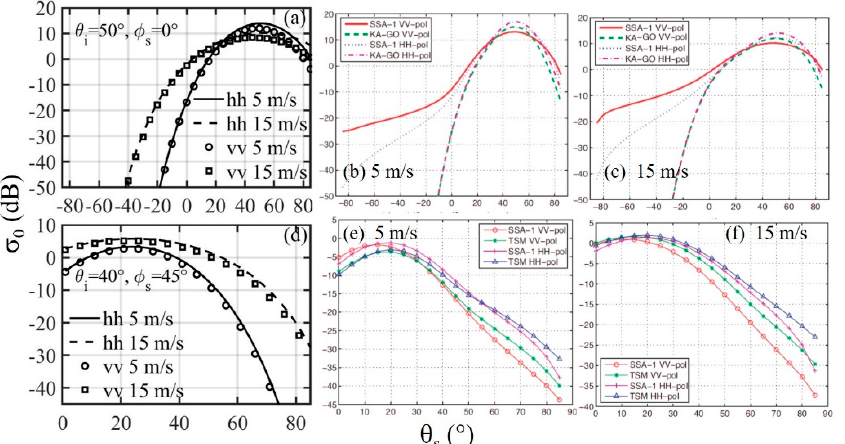
Figure 15. (Top row) Examples of in-plane NRCS dependence on θ s , f = 14 GHz, θ i = 50°. ( a ) Specu- lar point computation, U 10 = 5 and 15 m/s, ( b ) 5 m/s, and ( c ) 15 m/s SSA and GO solutions repro- duced from Figure 3 of A06. (Bottom row) Examples of out-of-plane forward scattering ( ϕ s = 45°) NRCS dependence on θ s , f = 14 GHz, θ i = 40°. ( d ) Specular point computation, U 10 = 5 and 15 m/s, ( e ) 5 m/s, and ( f ) 15 m/s SSA and GO solutions reproduced from Figure 6a and Figure 7a, respec- tively, of A06. Figure 15d shows the out-of-plane NRCS dependence on θ s for θ i = 40° and ϕ s = 45°. The high wind NRCS is larger than that of the low wind because of the broader beam-